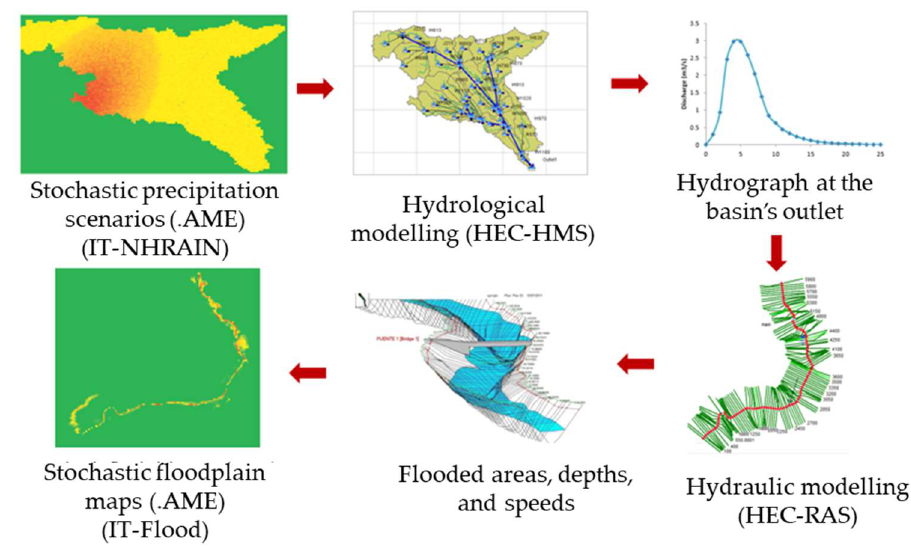
Figure 5. Sequence of the steps for the generation of stochastic flood scenarios.